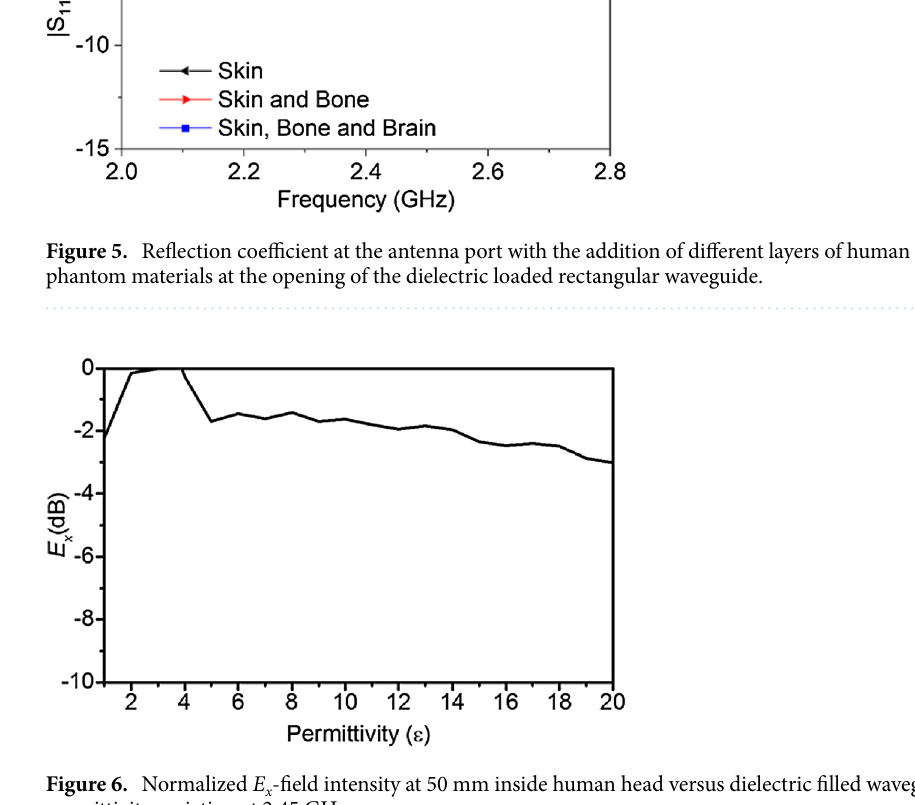
Figure 6. Normalized E x -field intensity at 50 mm inside human head versus dielectric filled waveguide permittivity variation at 2.45